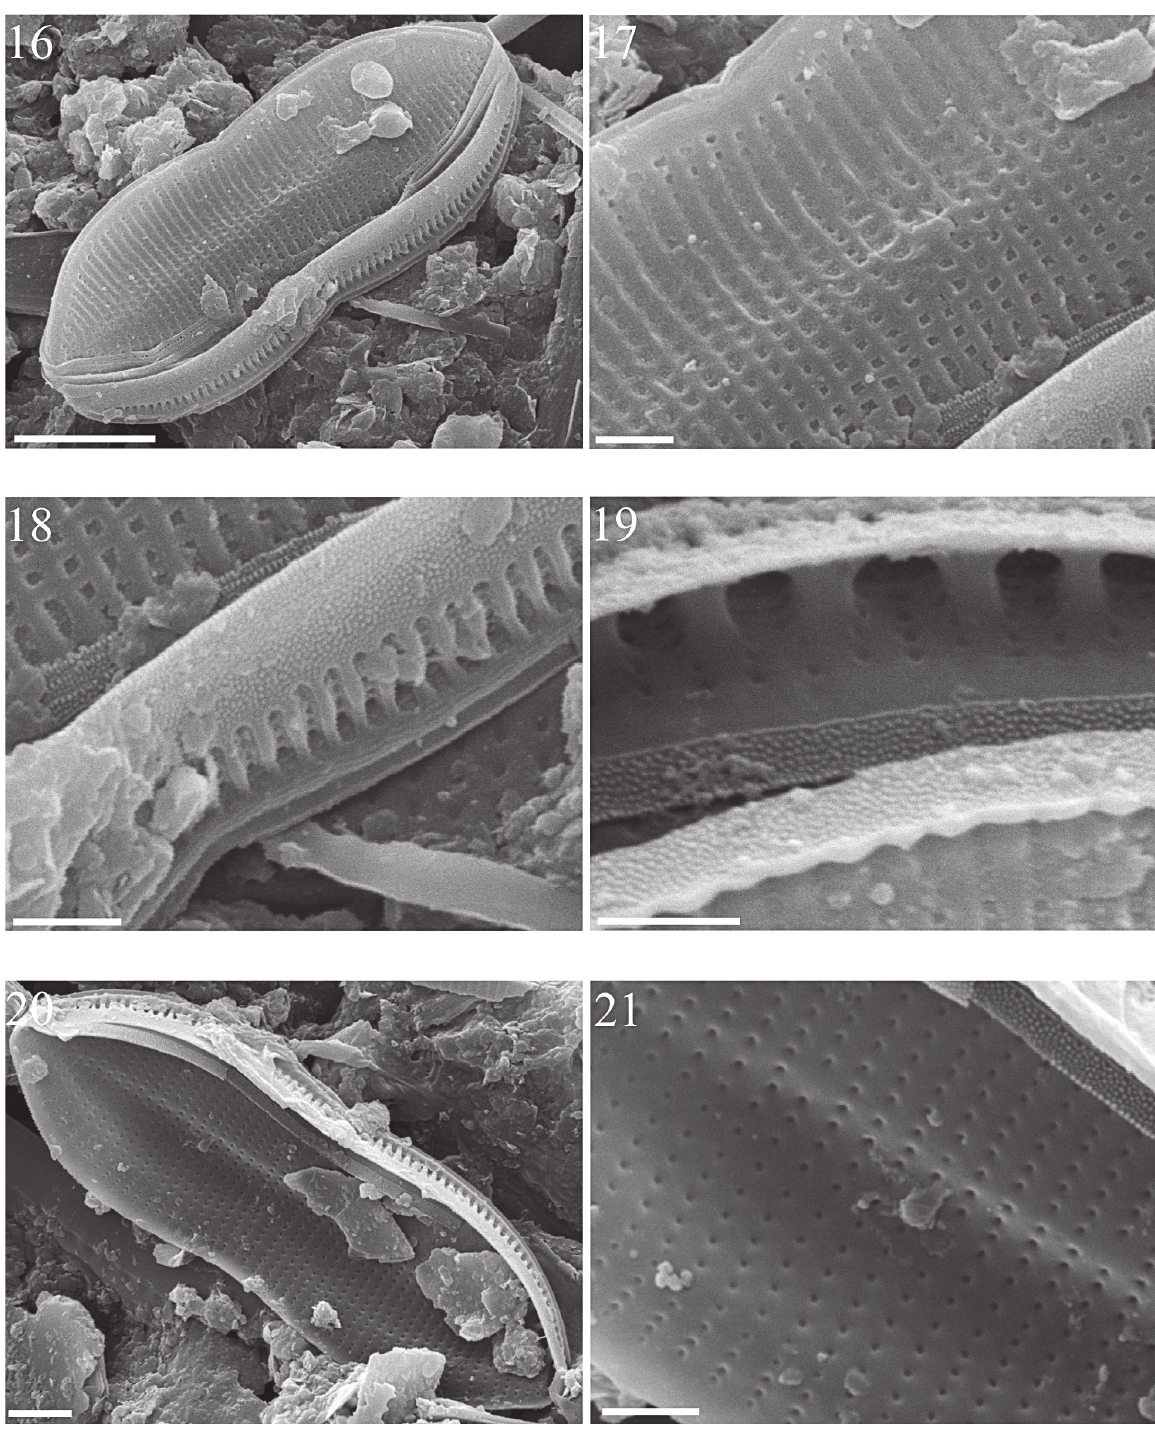
Figs 16-21 - Tryblionella persuadens comb. nov. in SEM. 16. External view of whole valve. 17. Detail of central valve face, showing poroids structure. 18. Detail of granulated mantle. 19. Internal view of fibulae structure. 20. Valve in internal view. 21. Detail of valve center in internal view, showing internal poroid aperture. Scale Bars: Figs 16 = 5 µm; Figs 17-19 , 21 = 1 µm; Fig. 20 = 2